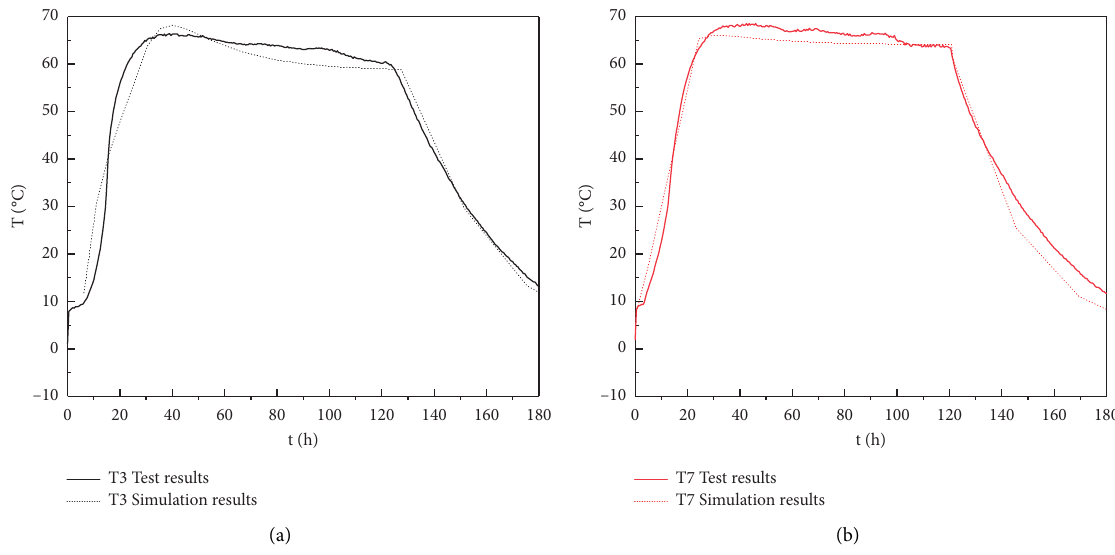
Figure 8: Comparison of finite element simulation results and test results at measurement locations (a) T3 and (b) T7. Table 5: Temperature field simulation parameters.